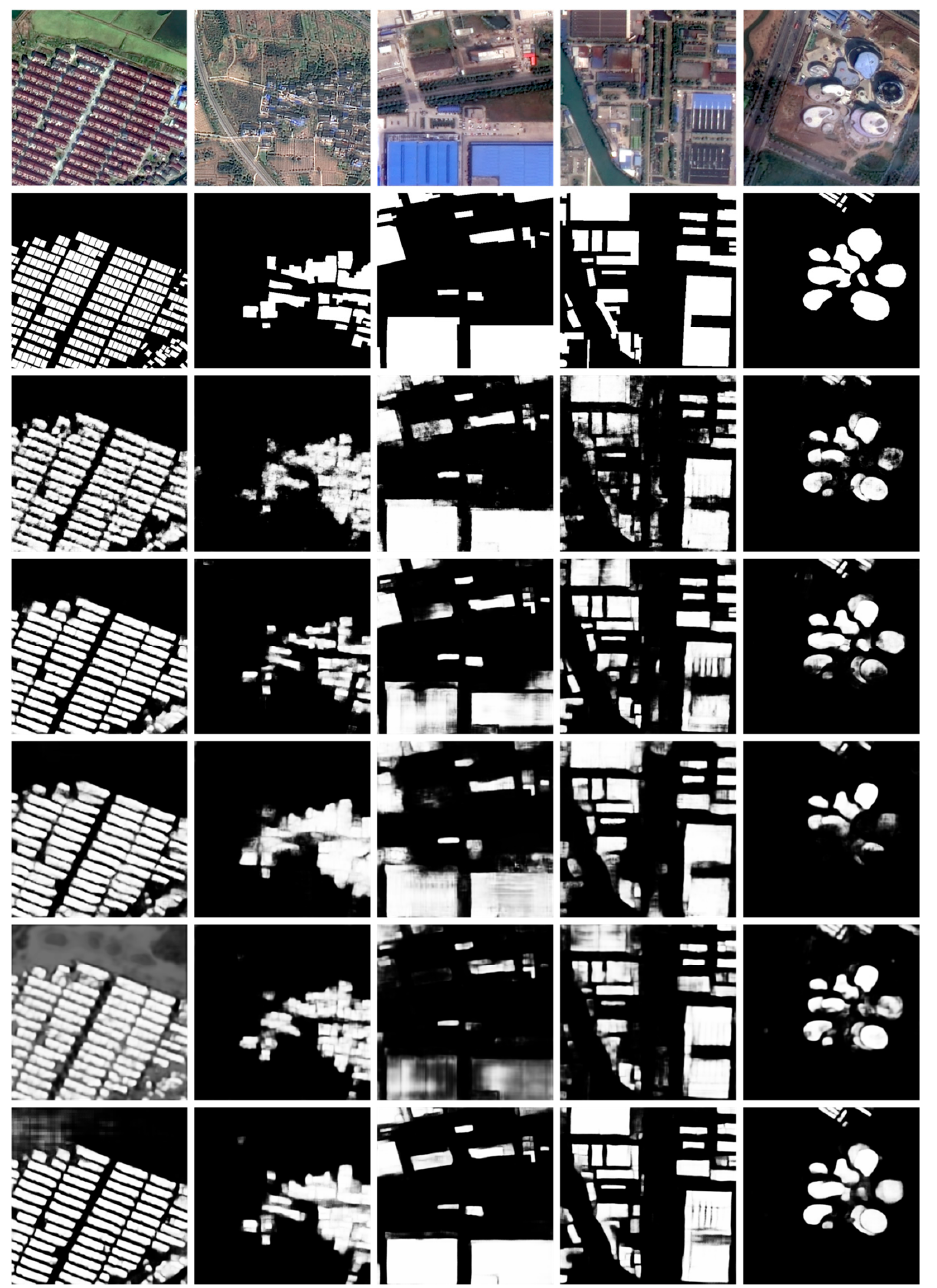
Figure 9. Building extraction results on the Suzhou dataset. The first two rows are images and corresponding ground truth. The rest five rows are produced by SegNet, U-Net, RefineNet, DeepLab v3+, and DE-Net.